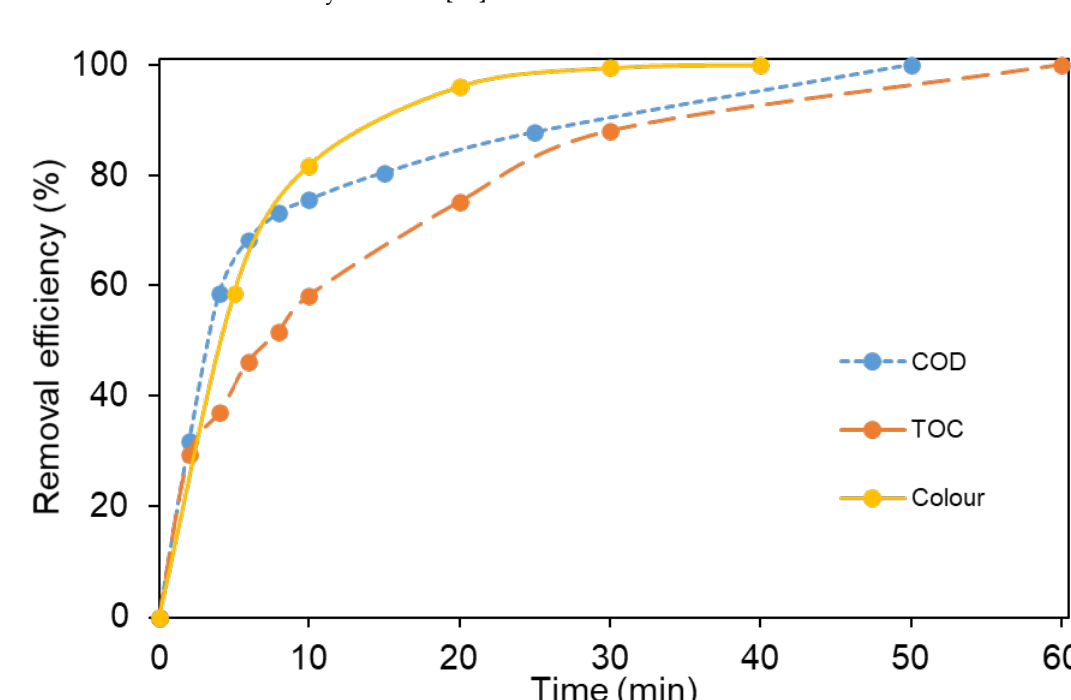
Figure 5. Variation of COD, TOC and color removal as a function of time during the electrochemical degradation of MB (50 mg/L) on the Ni 0.6 Co 0.4 -oxide anode at 20 mA/cm 2 in a 0.17 M Na 2 SO 4 aqueous solution containing 2 g/L NaCl salt. The initial (time zero) COD and TOC values were ca. 63 mg/L and 26.5 mg/L, respectively. The curves presented are the representative plots of the corresponding duplicate experiments.